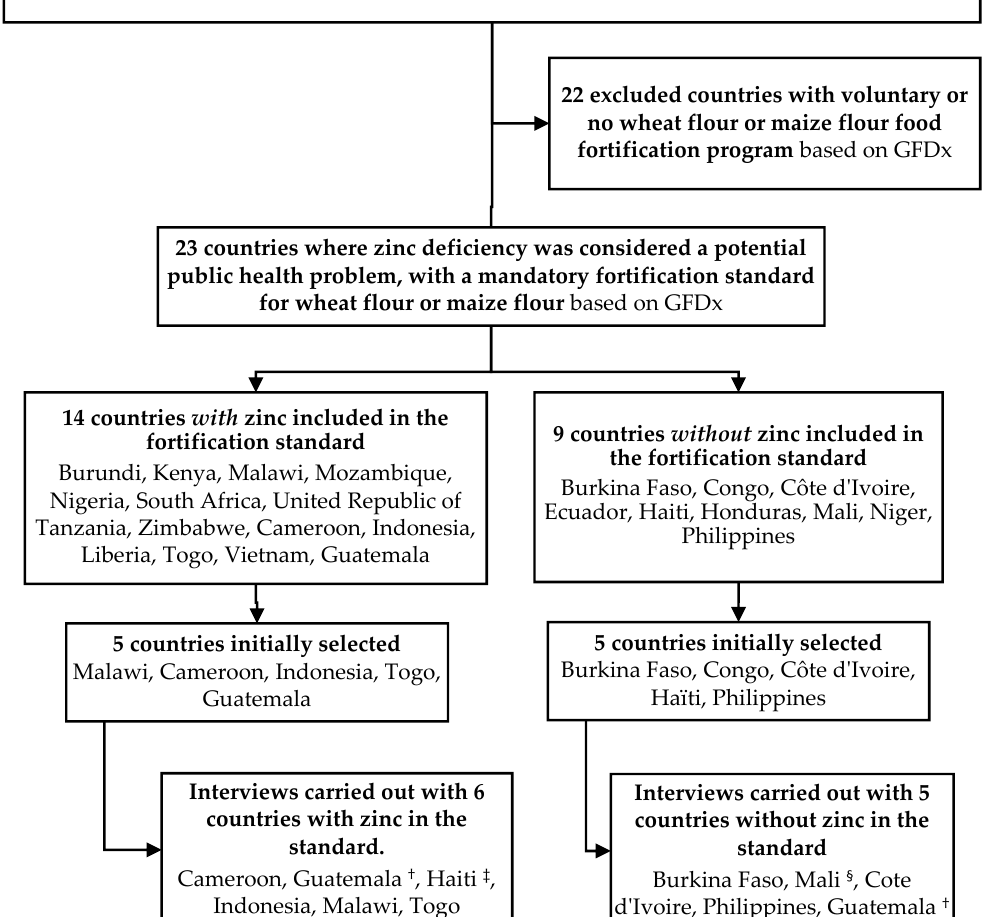
Figure 1. Country selection process. † Guatemala fortifies maize flour, but not wheat flour, with zinc; ‡ Haiti was initially selected as a country not fortifying with zinc but turned out to indeed be fortifying with zinc; § Mali replaced the Congo due to difficulties identifying a key informant in Congo. LMIC: low- and middle-income countries; PZC: plasma zinc concentration; PSC: preschool children; WRA: women of reproductive age.